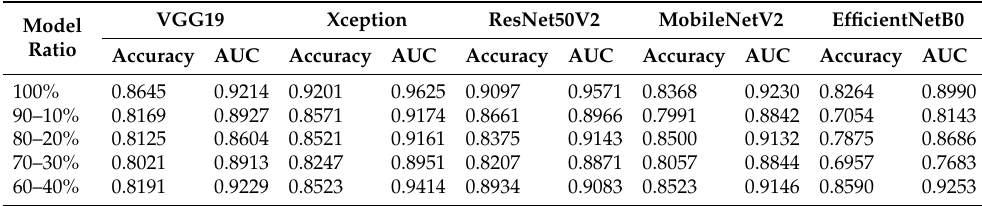
Table 5. Model performance for different train test split ratios.